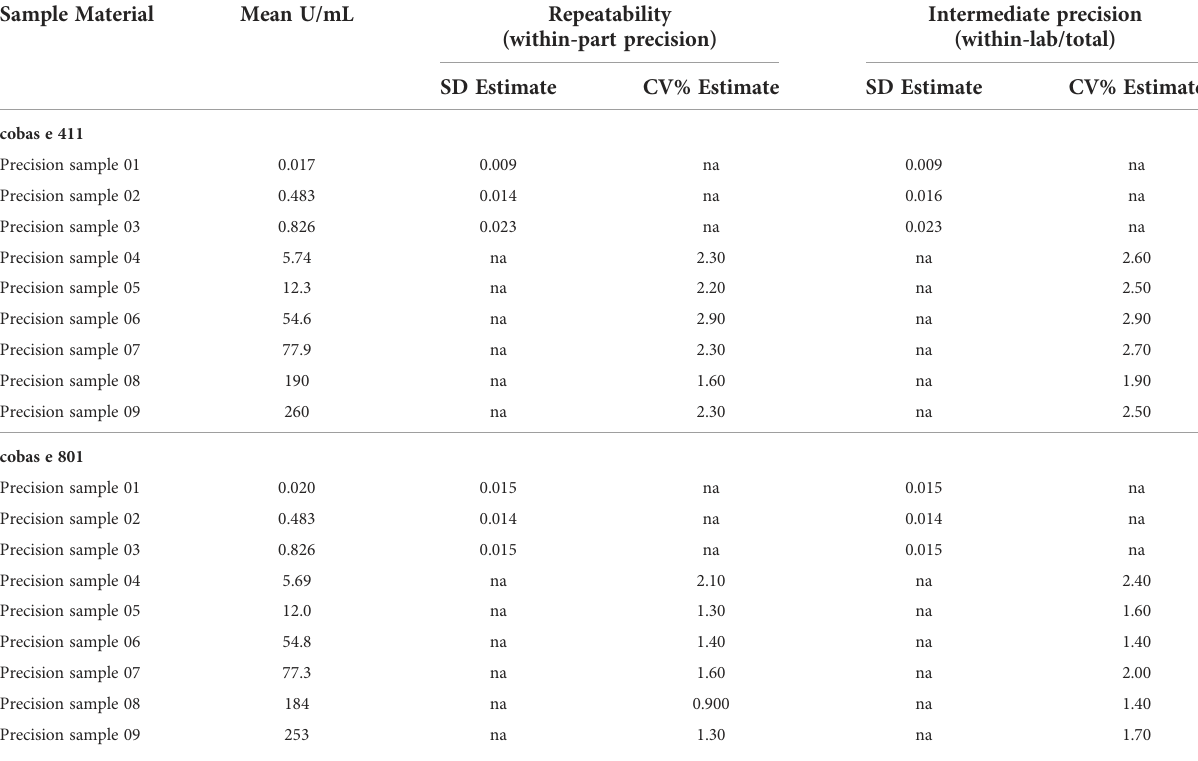
TABLE 3 Precision of the ACOV2S assay using the cobas e 411 and cobas e 801